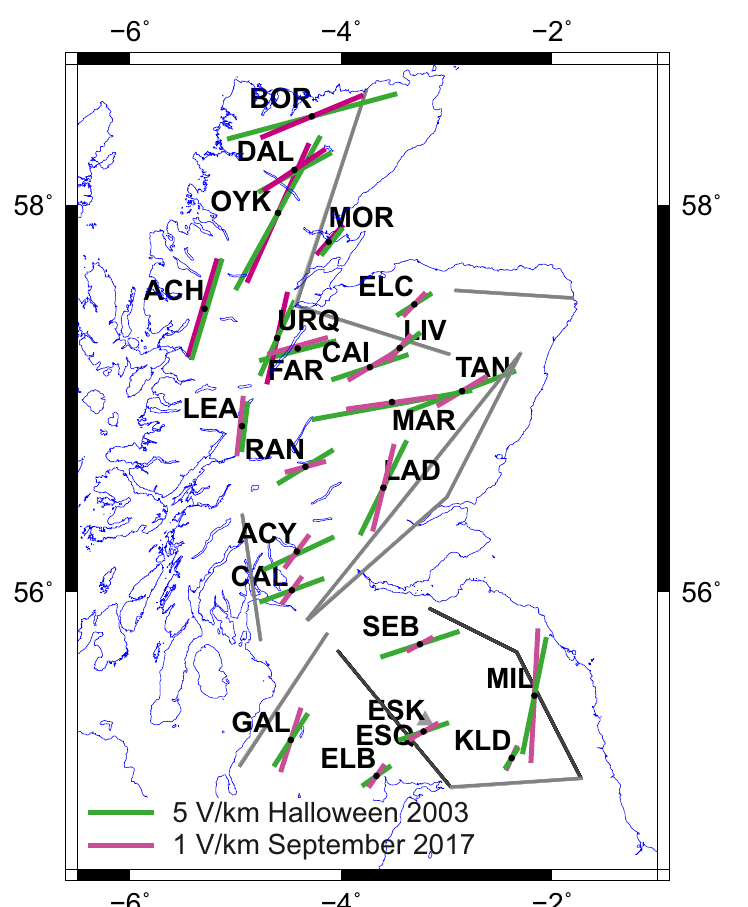
Fig. 11. Comparison of maximum peak-to-peak, storm-time, electric fi eld magnitudes and directions estimated for the Halloween storm at 21:20 UT on 30th October 2003 and September 2017 storm at 01:25 UT on 8th September 2017. In both cases, electric fi elds were estimated by multiplying storm-time, magnetic fi elds with Z ij from the individual site. For the Halloween 2003 storm, magnetic fi elds from ESK were used, whereas for the September 2017 storm, magnetic fi elds from RAN were used. Note 1:5 scaling of the lengths of the vectors for the two